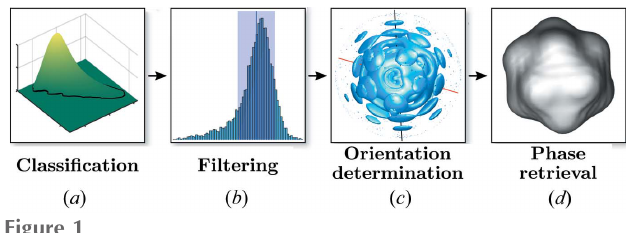
Figure 1 Workflow of the SPI experiment towards single-particle reconstruction: ( a ) single-hit classification of the initial data, ( b ) refined filtering of the classified data, ( c ) orientation determination, ( d ) particle reconstruction using phase retrieval.